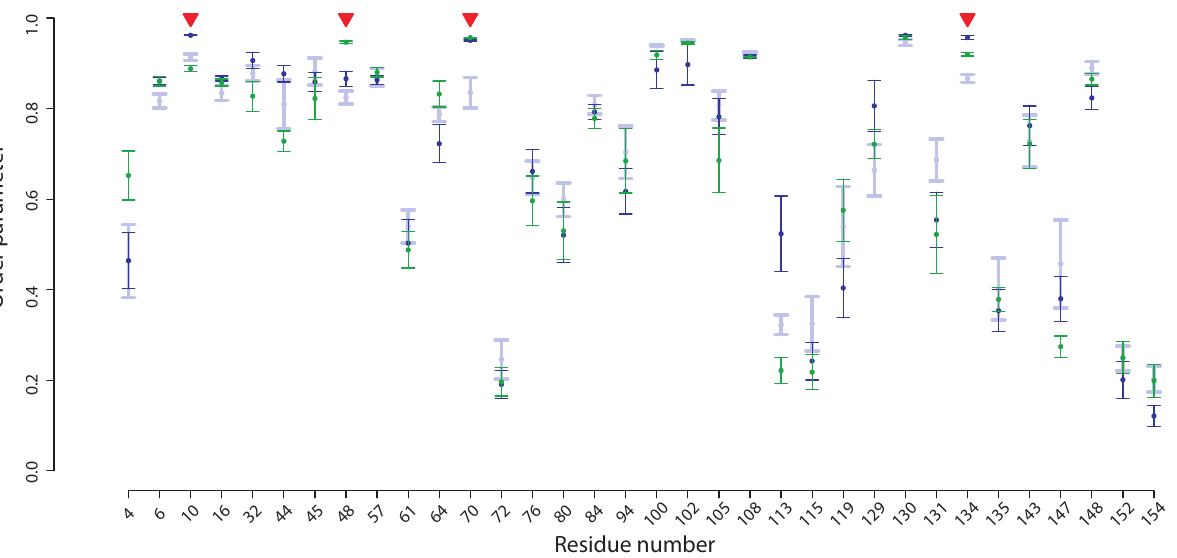
Figure 6. Differences in DENQ sidechain S 2 values in the presence of Mg 2+ ions in ecRNH. Calculated S 2 values are shown for various simulation conditions with standard errors of the mean: ecRNH apo (light blue), A site (dark blue), B site (green). The four active-site residues are indicated with red triangles. In no case does the difference between any two simulations reach statistical significance.